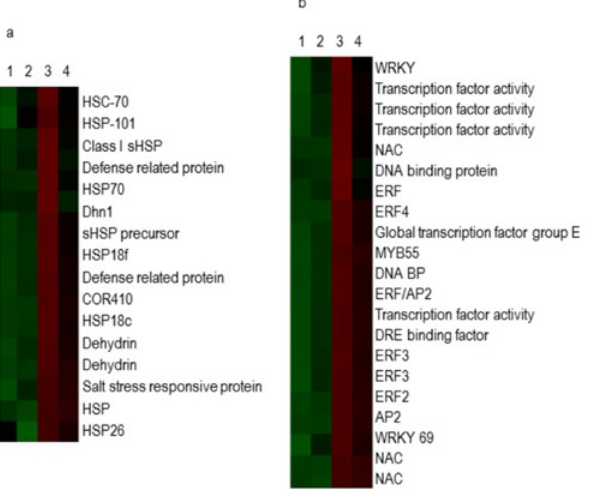
Fig 9. Hierarchical clustering of transcriptional responses of different classes of genes in the two maize genotypes: a) Heat Shock Proteins, Late Embryogenesis Abundant proteins and dehydrins; b) transcription factors. Sample numbers are indicated on the top: 1) DKC6575 at T2 drought stress; 2) DKC6575 at T2 control condition; 3) Tietar at T2 drought stress; 4) Tietar at T2 control condition. A heat map was generated by Java TreeView 1.60 software. Each colored block represents the expression of one gene (labeled on the right) in the indicated sample. Expression signals are converted into color (red, high signal; green, low signal). A (cid:2) 2 fold change is shown in red, a fold change (cid:3) 0.5 in green and no change in black. Color intensities are proportional to the variation of expression.